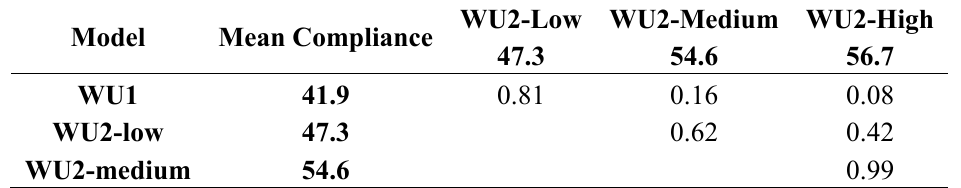
Table 6. Mean compliance of standardized index values and adjusted (with respect